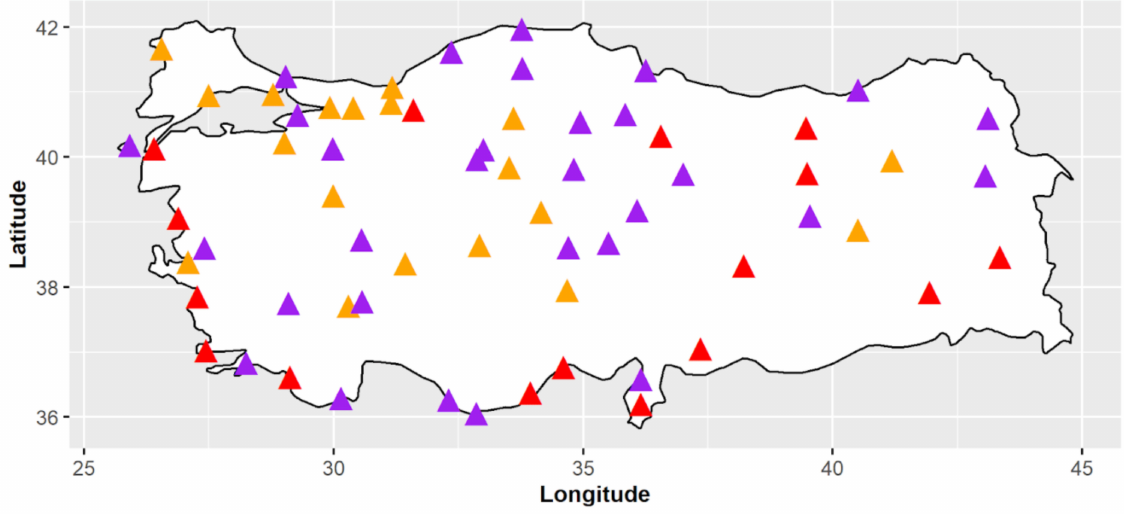
Figure A23. Same as Figure A13 but for October (See Figure A13 for legend).